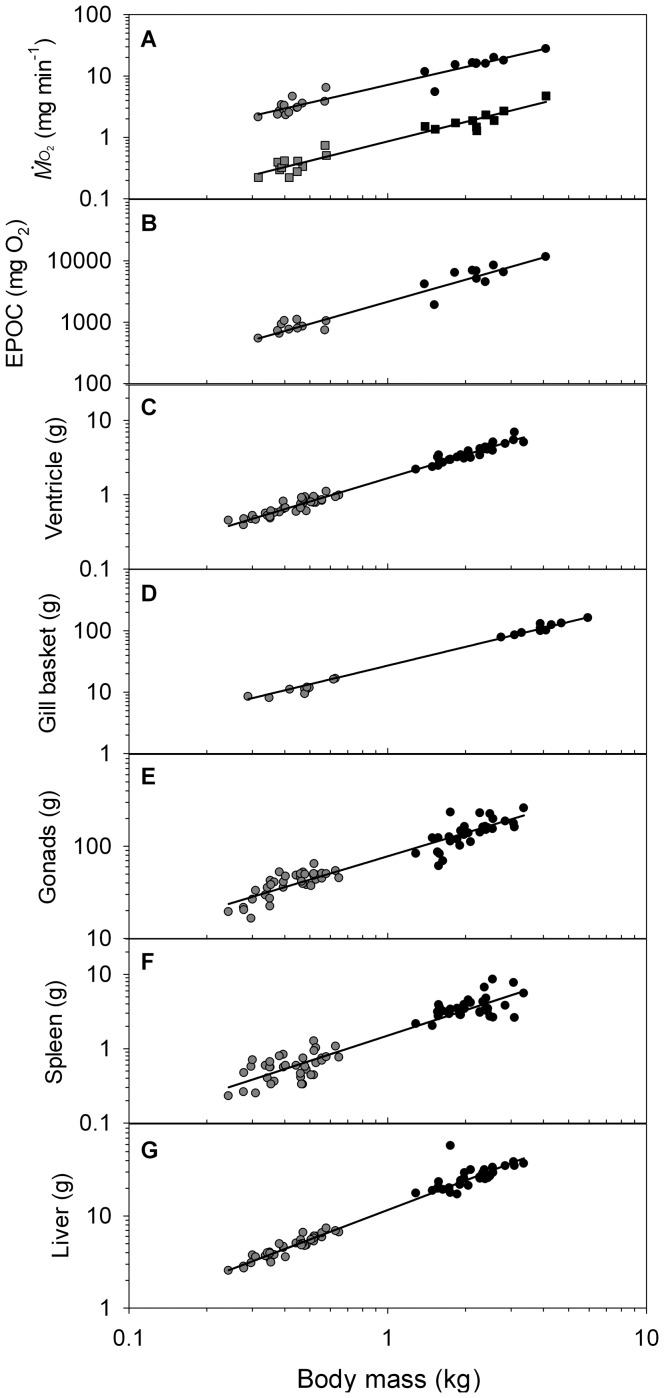
Relationships between body mass (M
b) and metabolic and anatomical parameters of coho salmon (O. kisutch).(A) minimum (squares) and peak (circles) oxygen consumption rate (
min and 
peak, respectively), (B) excess post-exercise oxygen consumption (EPOC), and (C–G) anatomical parameters. Only data for full-size males (black) and jacks (grey) are presented to remove variability associated with sex-specific differences. Regression lines (with standard errors in parentheses) are described by: (A) 
min = 0.861 (0.047) • M
b
1.053 (0.063) (R2 = 0.935, P<0.001), 
peak = 7.103 (0.339) • M
b
0.968 (0.056) (R2 = 0.935, P<0.001); (B) EPOC = 2154.6 (136.9) • M
b
1.196 (0.075) (R2 = 0.927, P<0.001); (C) ventricle mass = 1.662 (0.022) • M
b
1.045 (0.016) (R2 = 0.985, P<0.001); (D) gill basket mass = 25.519 (0.589) • M
b
1.061 (0.020) (R2 = 0.993, P<0.001); (E) gonad mass = 76.906 (2.113) • M
b
0.824 (0.033) (R2 = 0.907, P<0.001); (F) spleen mass = 1.503 (0.060) • M
b
1.134 (0.047) (R2 = 0.897, P<0.001); (G) liver mass = 11.625 (0.236) • M
b
1.066 (0.024) (R2 = 0.968, P<0.001).